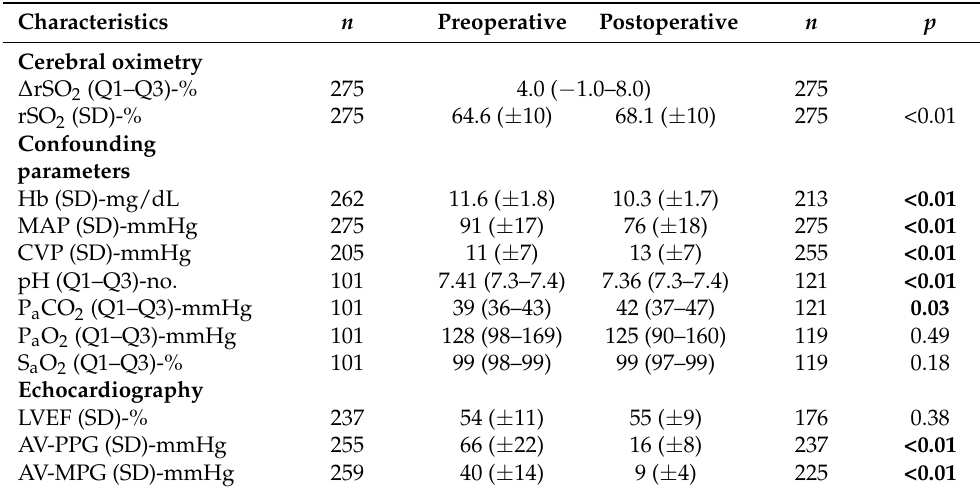
Table 3. Overall rSO 2 , hemodynamic confounders and follow-up